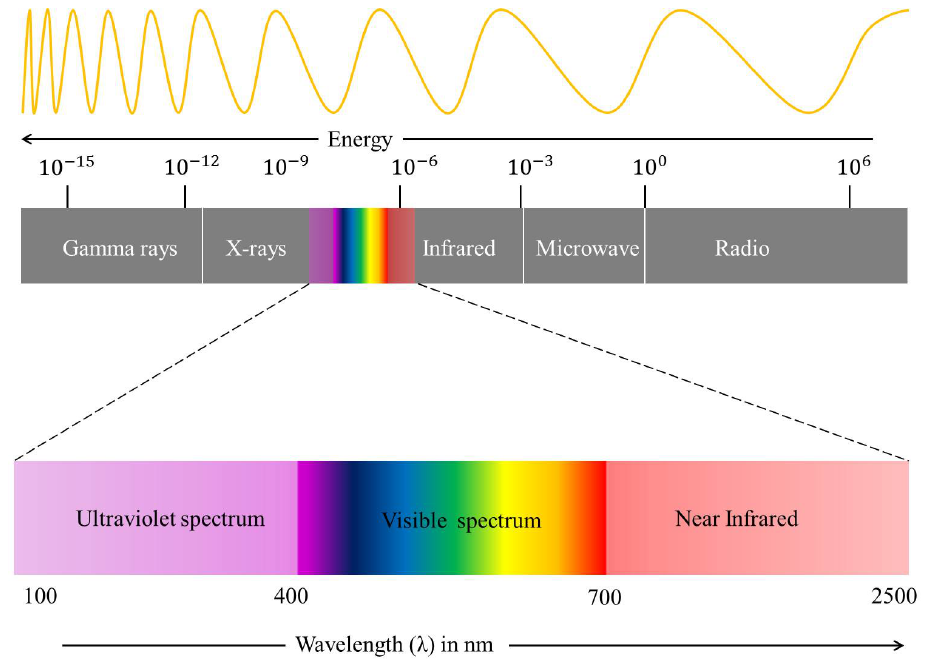
Figure 1. Electromagnetic spectrum according to energy along with ideal transmission window for